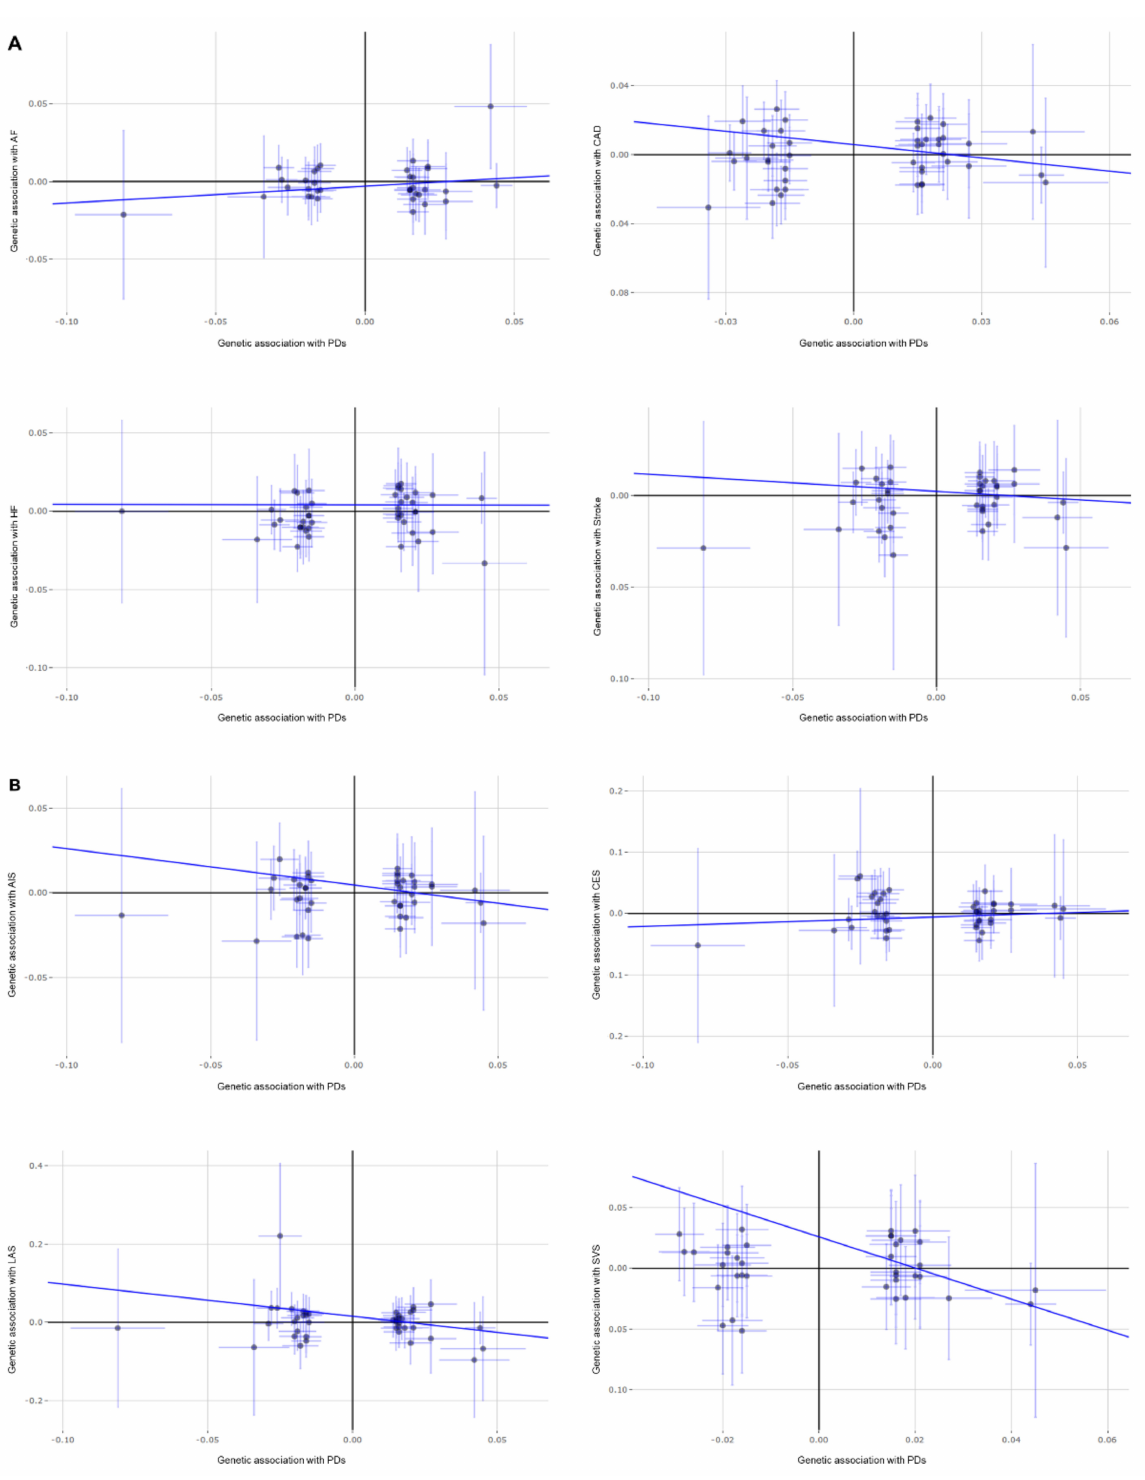
Figure 1. MR analysis for the association of genetically proxied dental caries and periodontitis with cardiovascular diseases: ( A ) MR analysis for CAD, HF, AF, and stroke; ( B ) MR analysis for any ischemic stroke (AIS) as well as its three main subtypes (CES, LAS, and